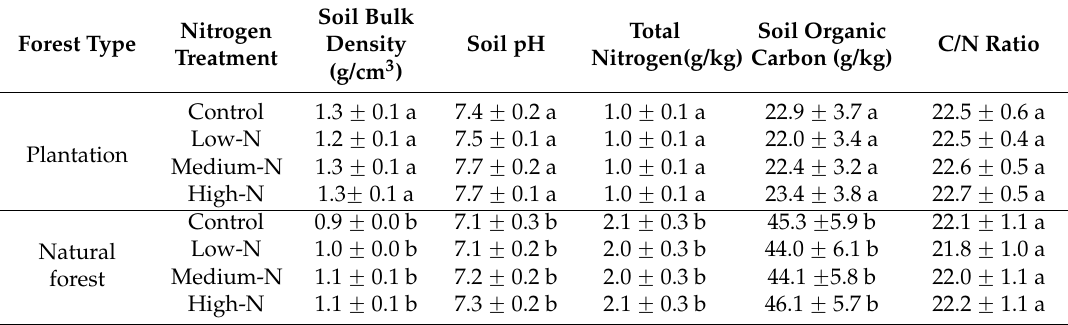
Table 2. Mineral soil properties (0–20 cm) of four N addition treatment plots in the plantation and natural forests of Chinese pine (Mean ˘ SE, n =